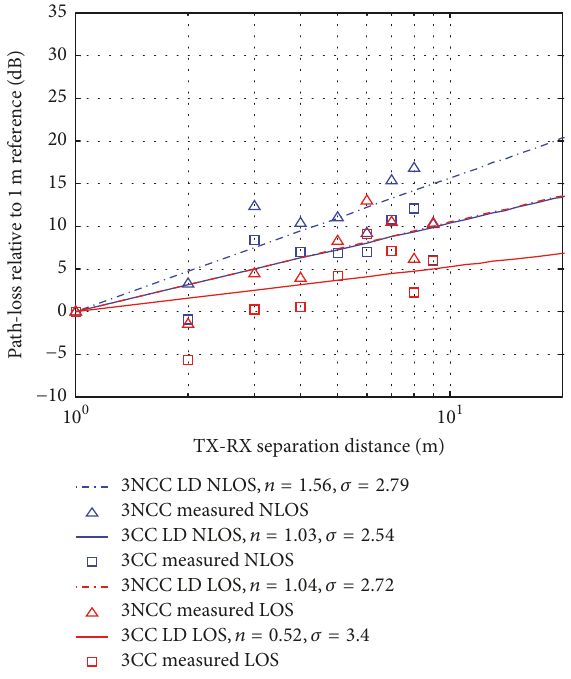
Figure 4: LDMs along with the measured scattered data when combining three signals coherently and noncoherently for the LOS and NLOS propagation scenarios.